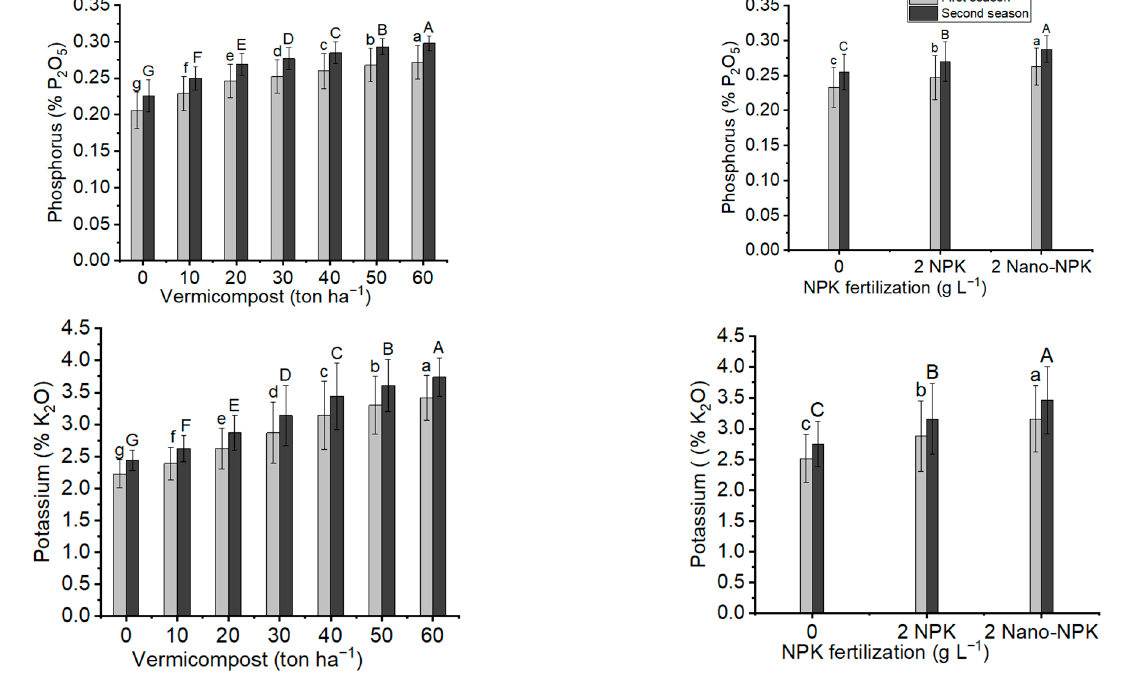
Figure 7. In both seasons of the study, the mean values of phosphorus content (% P 2 O 5 ) and potassium content (% K 2 O) of Moringa oleifera trees as influenced by vermicompost and NPK fertilization are provided below. The data are presented as a mean with standard error ( n = 3). Bars with identical lowercase letters are not significant at the 0.05 level of probability. Table 9. The influence of combined treatments of vermicompost and NPK fertilization on the mean values of phosphorus content (% P 2 O 5 ) and potassium content (% K 2 O) of Moringa oleifera trees in the first and second seasons. The mean values of phosphorus content (% P 2 O 5 ) and potassium content (% K 2 O) of Moringa oleifera leaves as affected with organic fertilization and mineral fertili- zation combination treatments in both seasons of the study.